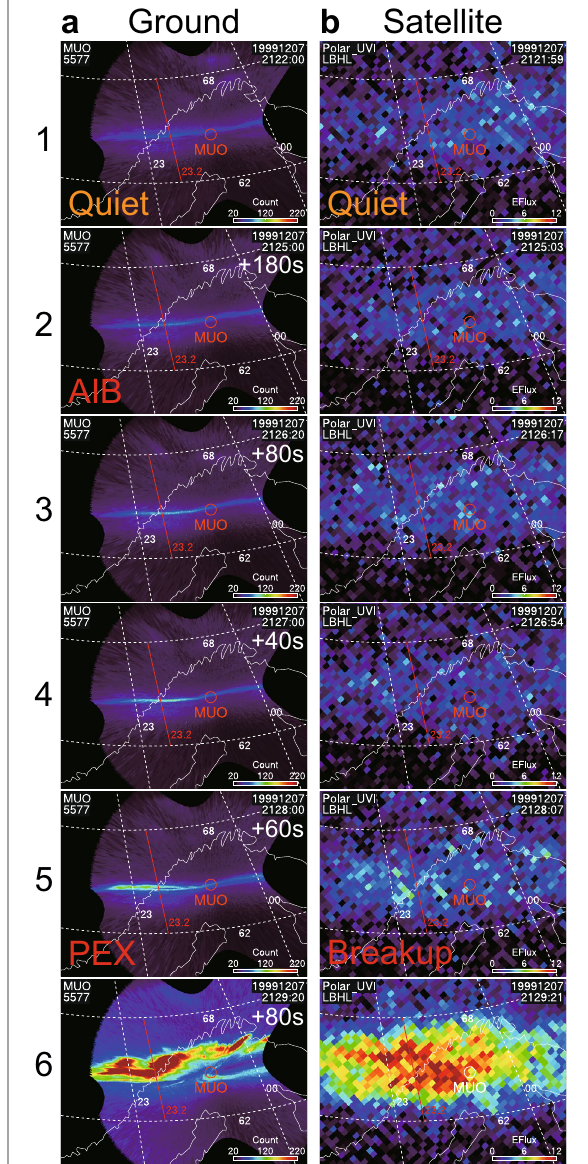
Fig. 6 Comparison of a ground-based and b satellite-based auroral images on December 7, 1999. The time sequence of selected auroral images is shown from top to bottom. All images are projected to the same area in geodetic coordinates. a Ground-based all-sky images (ASIs; 557.7 nm) at the Muonio station (MUO) in Finland. These ASIs were selected to show the observed instances a1 during the quiet interval, a2 at the start of Akasofu initial brightening (AIB), a3 – a4 during AIB, a5 at the start of poleward expansion, and a6 during poleward expansion. b Global images (170 nm) taken by the Polar satellite ultraviolet imager (UVI). Each image was selected to form a pair with an ASI in a within 7 s. A comparison of a and b reveals that the longitudinally extended brightening (AIB) can be marginally observed in a2 and is evident in a3 – a4 but not in b2 – b4 . In contrast, the brightening a5 that corresponds to the beginning of the poleward expansion was simultaneously observed in